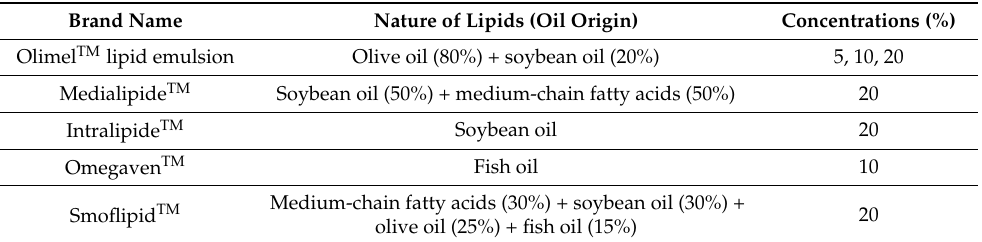
Table 2. Nature and concentration of lipid emulsions used for stability study.